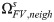
Comparison of pressure fields computed via hybrid and CN approaches.(a) The pressure fields are displayed for two configurations of interest: (i) centered and (ii) off-centered single coupling of an arteriolar vessel in a 6-regular capillary network. The coupling point is indicated by a large orange dot. In the off-centered case, the coupling condition is either distributed among neighbouring cells ΩFV,neighs or not. (b) Pressure profiles are plotted along a line of interest, which is indicated by orange dashes in (a). The reference pressure field from CN approach is represented by orange crosses. Green steps represent cell pressures of the FV representation, blue and red lines respectively represent linear and spherical approximations. Black dashed lines represent the limit of ΩFV,neighs, where pressure field is approximated by analytical solutions. The reconstructed pressure field of the hybrid approach is finally obtained by combining solid lines. The asymmetry of the field far away from the source is caused by the imposed boundary conditions at the limits of the domain. Here πref = 5 000 Pa is a reference pressure value used for nondimensionalization.